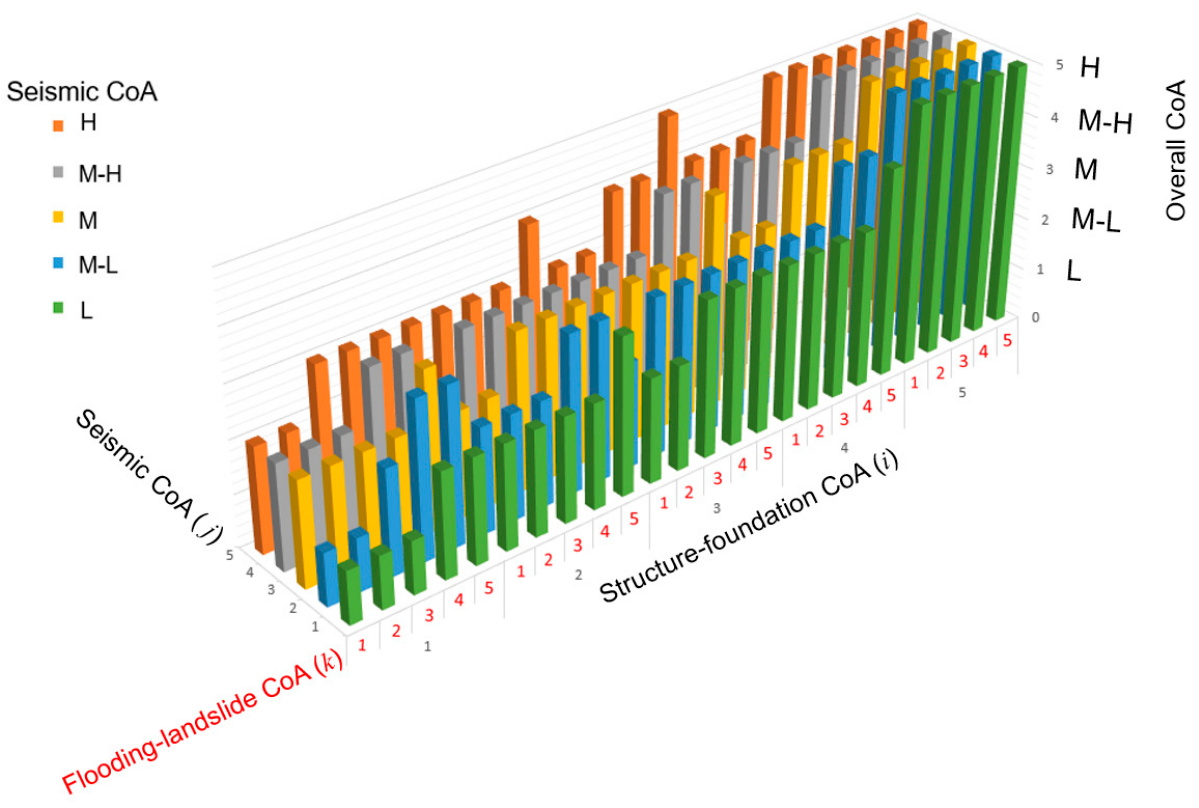
Figure 10. Overall class of attention as a function of structure-foundation, seismic and flooding-landslide CoAs.